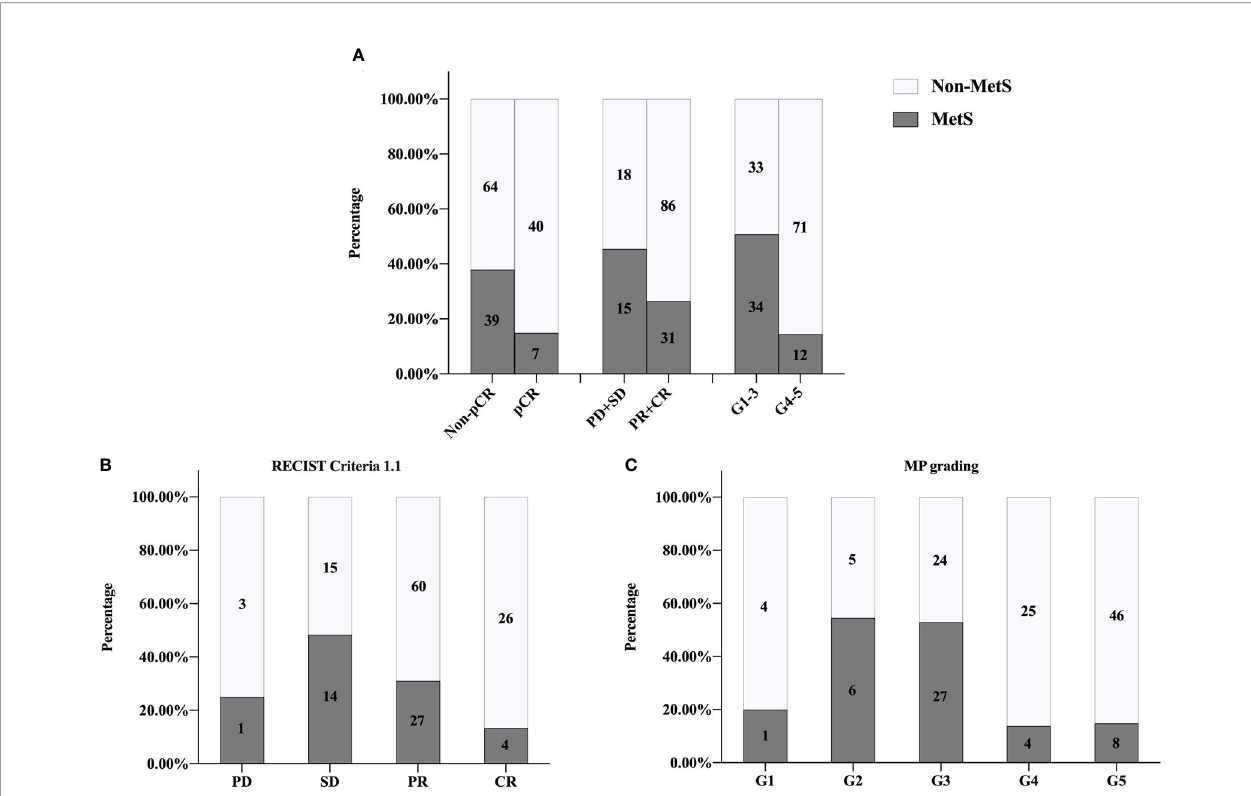
FIGURE 2 | Univariate analysis of relationship between MetS and NACT response. (A) pCR, P = 0.003; clinical responses, P = 0.033; pathologic responses, P <0.001. (B) RECIST1.1 criteria P = 0.004. (C) MP grading P < 0.001. MetS, metabolic syndrome; pCR, pathologic complete response; PD, progressive disease; SD, stable lesions; PR, partial response; CR, complete response; MP, Miller-Payne; RECIST, response evaluation criteria in solid